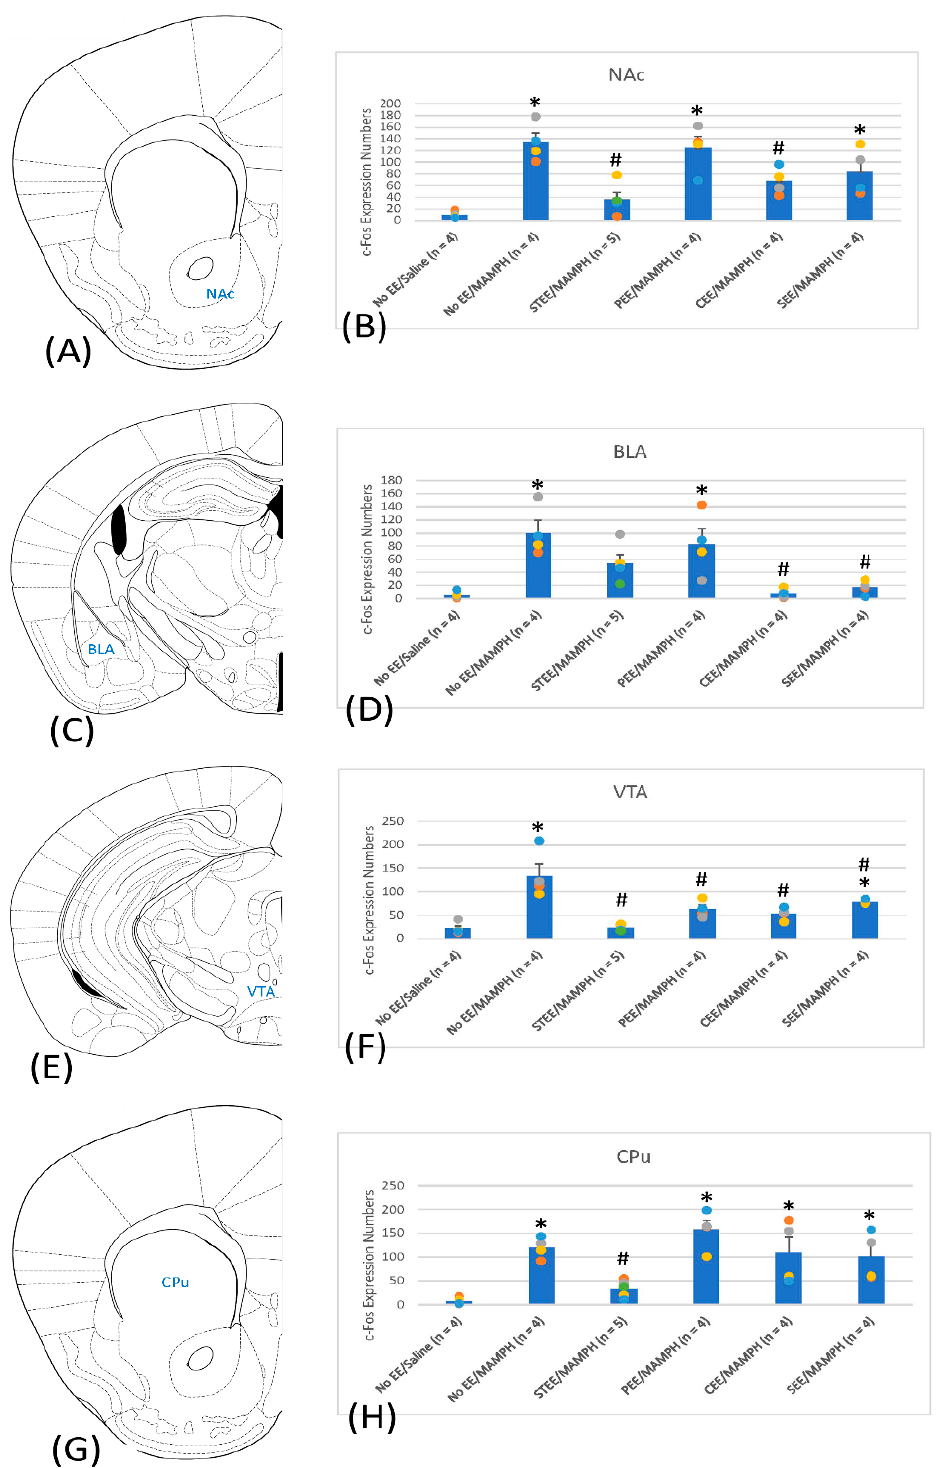
Figure 3. A cartoon brain atlas showing ( A ) the nucleus accumbens (NAc), ( C ) basolateral amygdala (BLA), ( E ) ventral tegmental area (VTA), and ( G ) caudate-putamen (CPu) and c-Fos expression in ( B ) the NAc, ( D ) BLA, ( F ) VTA, and ( H ) CPu for the No environmental enrichment (EE)/Saline ( n = 4), No EE/methamphetamine (MAMPH; n = 4), standard EE (STEE)/MAMPH ( n = 5), physical EE (PEE)/MAMPH ( n = 4), cognitive EE (CEE)/MAMPH ( n = 4), and social EE (SEE)/MAMPH ( n = 4) groups; * p < 0.05 compared with the No EE/Saline group, and # p < 0.05 compared with the No EE/MAMPH group.